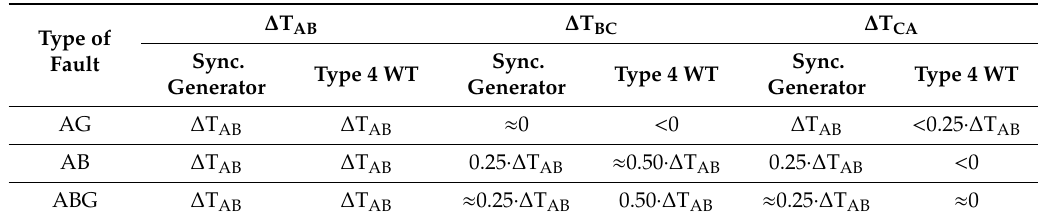
Table 3. Summary of results obtained in the comparison done between synchronous generator and Type 4 WT with AG, AB and ABG fault using instantaneous scalar